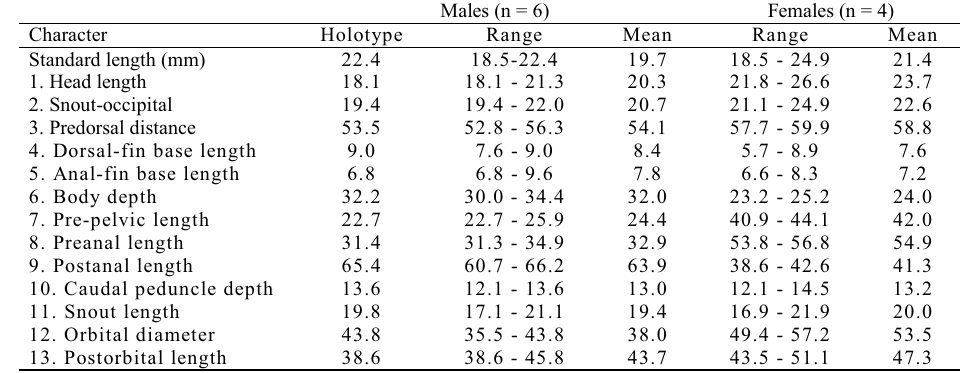
Table 2. Descriptive morphometrics of specimens of Cnesterodon iguape , new species. Measurements 1-10 are percents of standard length and measurements 11-13 are percents of head